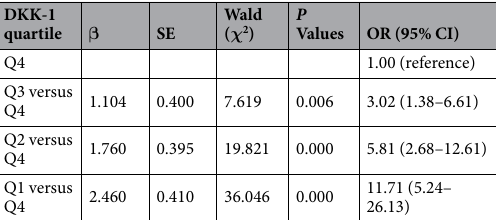
Table 4. OR and 95% CI for the Association between Plasma DKK-1 Quartiles with the Prevalence of Exudative AMD. OR = Odds Ratios; CI = 95% Confidence Intervals; DKK-1 = dickkopf-1; AMD = age- related macular degeneration. Q1, < 393.79; Q2, 393.80~527.73; Q3, 527.74~737.18, and Q4 > 737.19 pg/mL. Unconditional logistic regression